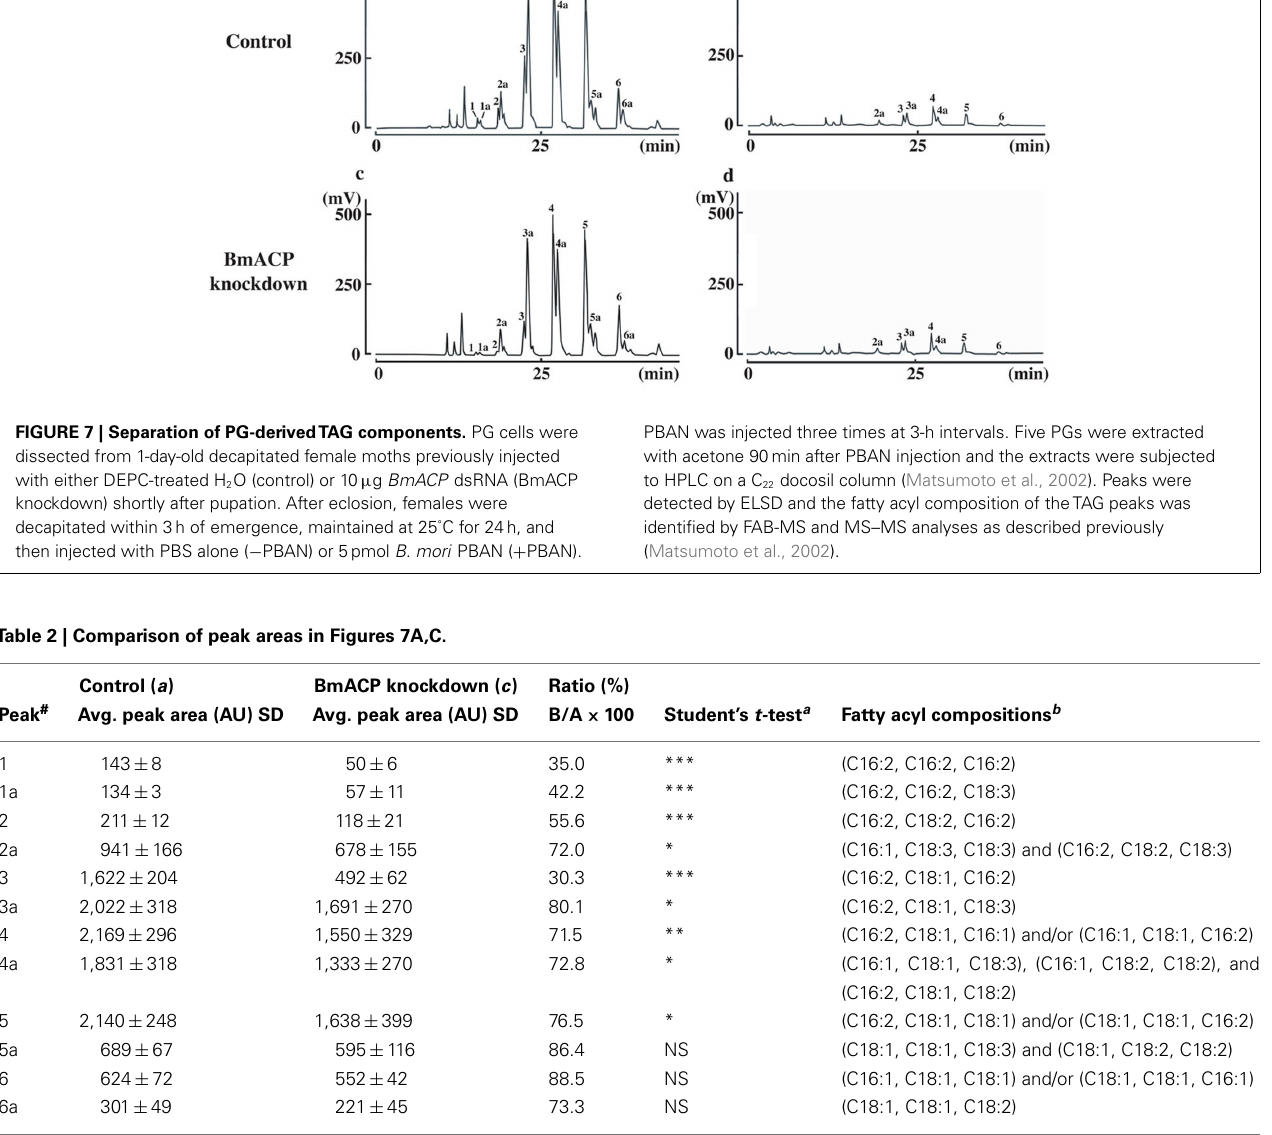
PBAN was injected three times at 3-h intervals. Five PGs were extracted with acetone 90min after PBAN injection and the extracts were subjected to HPLC on a C 22 docosil column (Matsumoto et al., 2002). Peaks were detected by ELSD and the fatty acyl composition of theTAG peaks was